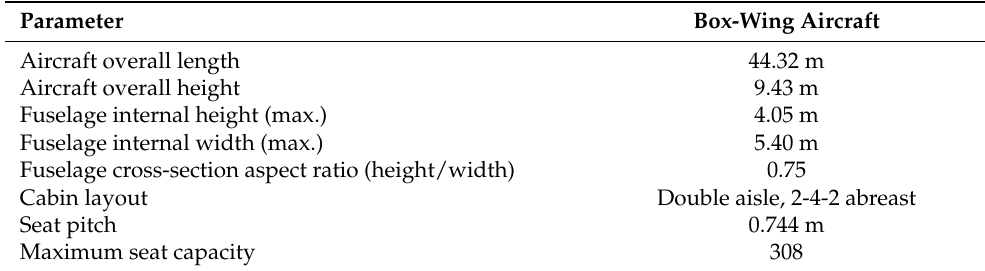
Table 1. Main characteristics of the box-wing aircraft studied in the project PARSIFAL. Parameter Box-Wing Aircraft Aircraft overall length 44.32 m Aircraft overall height 9.43 m Fuselage internal height (max.) 4.05 m Fuselage internal width (max.) 5.40 m Fuselage cross-section aspect ratio (height/width) 0.75 Cabin layout Seat pitch Maximum seat